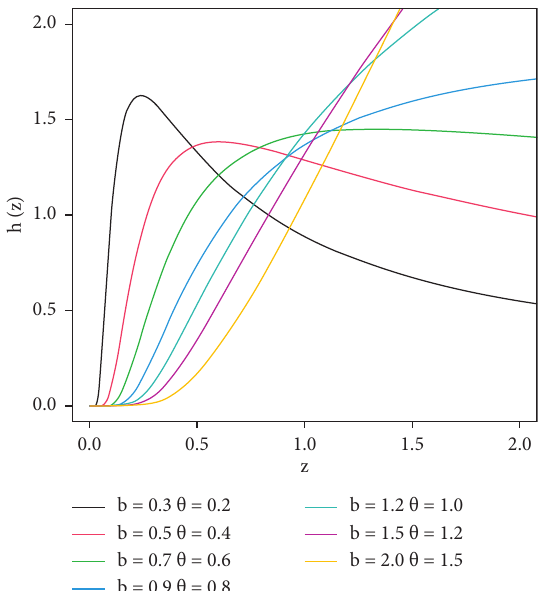
Figure 2: The cdf of the TIIFILi model for various parameter